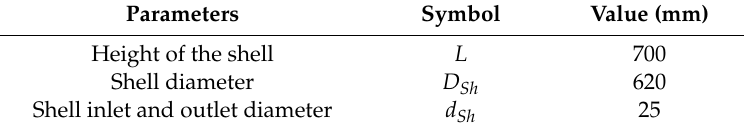
Table 4. Shell geometrical parameters.